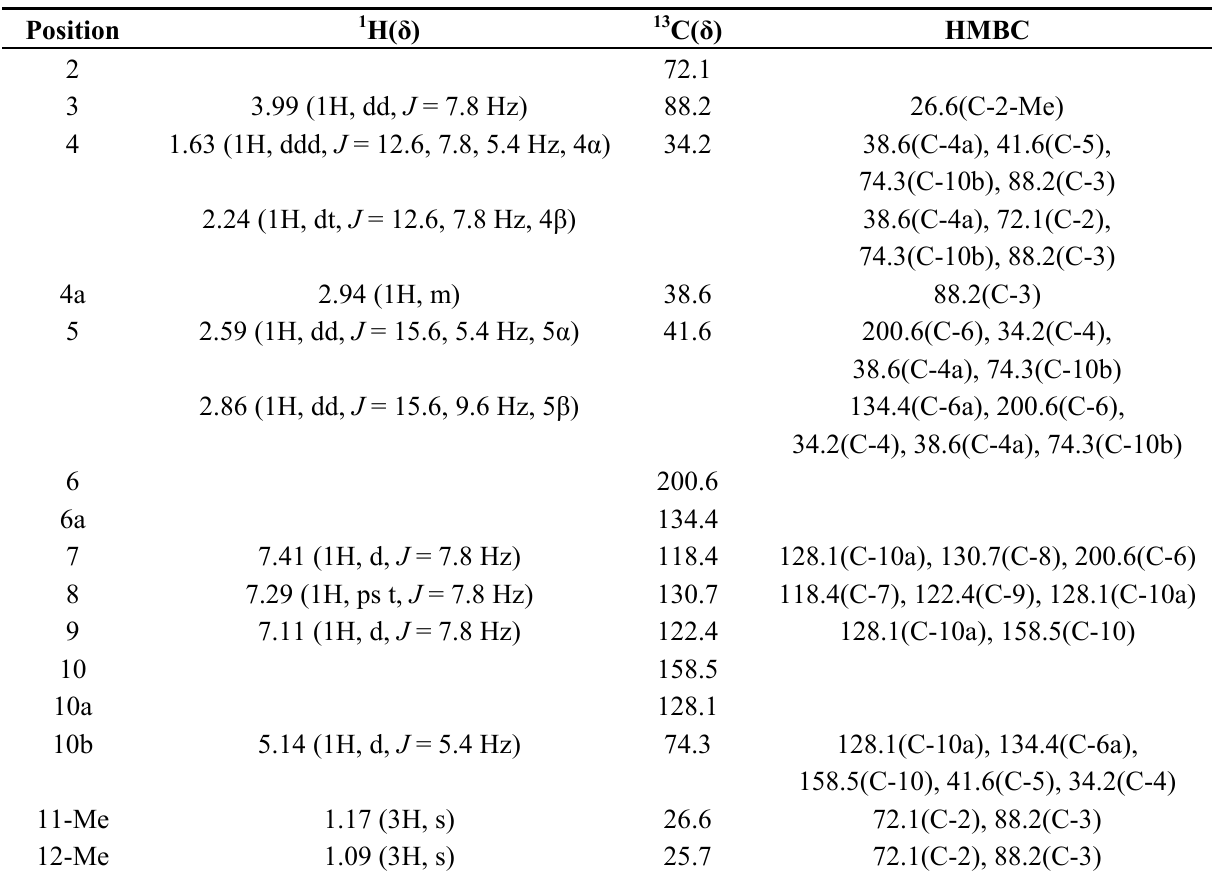
OD) and 13 C-NMR (150 MHz, CD 3